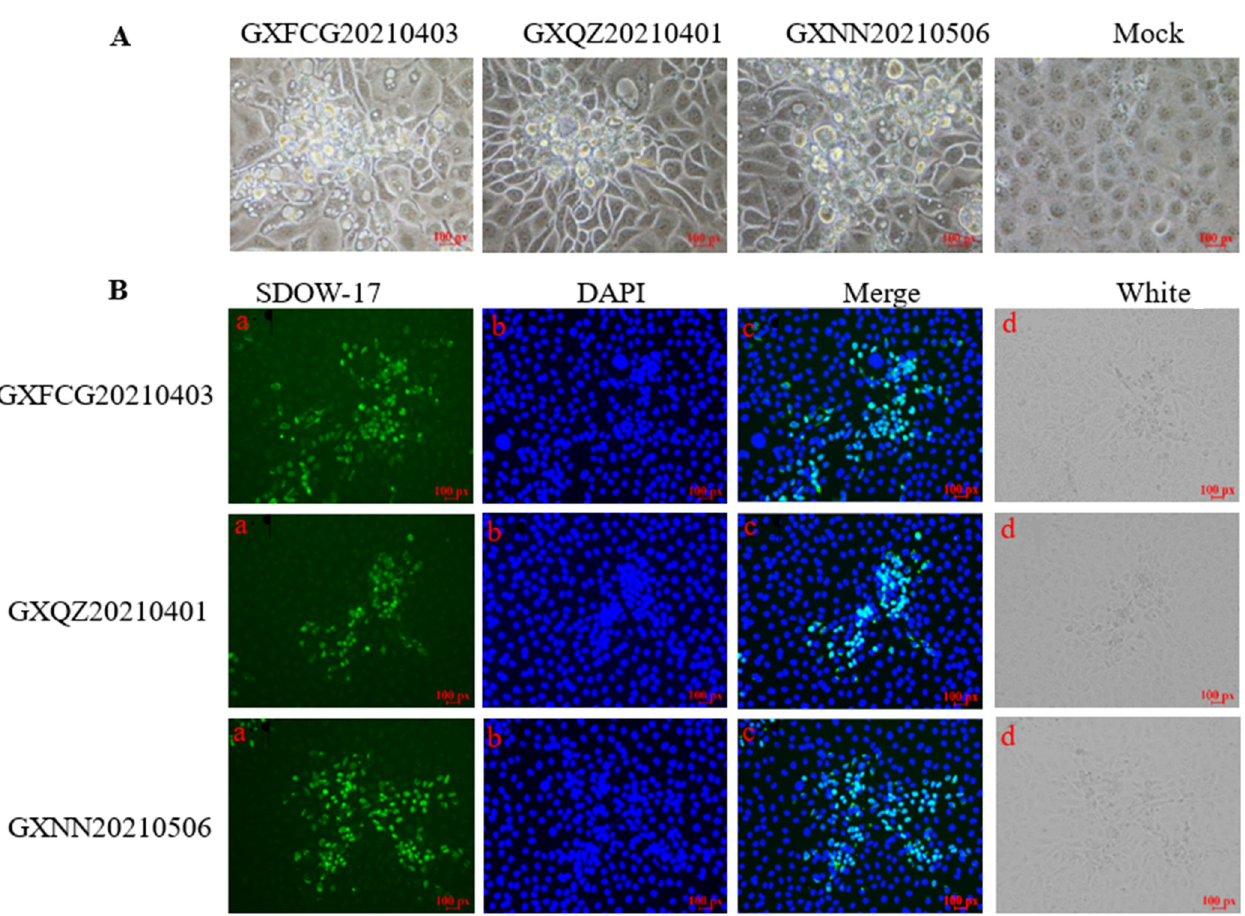
Figure 1. ( A ) Cytopathic effect (CPE) in MARC145 cells at 72 h post-infection with GXFCG20210403, GXQZ20210401, GXNN20210506 and Mock, respectively. Scale bar = 100×. ( B ) The existence of GXFCG20210403, GXQZ20210401 and GXNN20210506 was confirmed by IFA staining using a PRRSV-specific N protein monoclonal antibody, SDOW-17, as shown in ( a ). Nuclei were counterstained with DAPI and can be visualized in blue ( b ). The combined images of staining with N-mAb and DAPI are shown in ( c ). The photomicrograph ( d ) shows the infection state of MARC145 cells after fixation under white light irradiation. Scale bar = 100×.